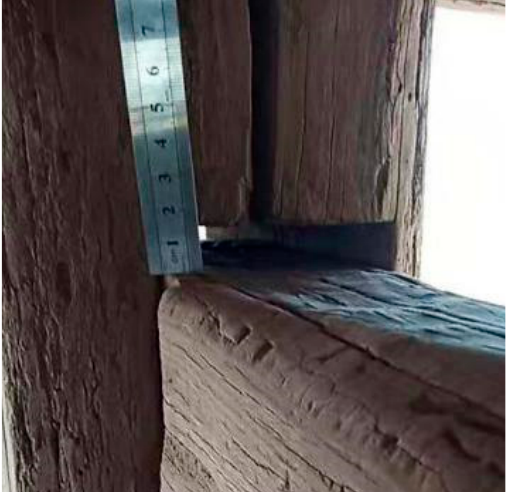
Figure 4. Local measurement of gap value of the mortise–tenon joint.